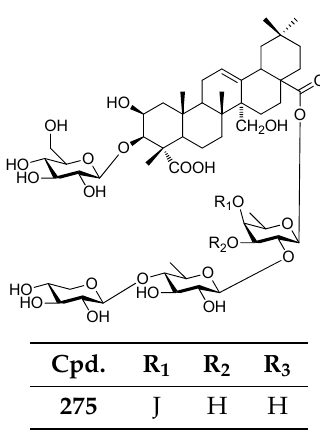
Figure 57. Structures of compounds 262 – 274 .